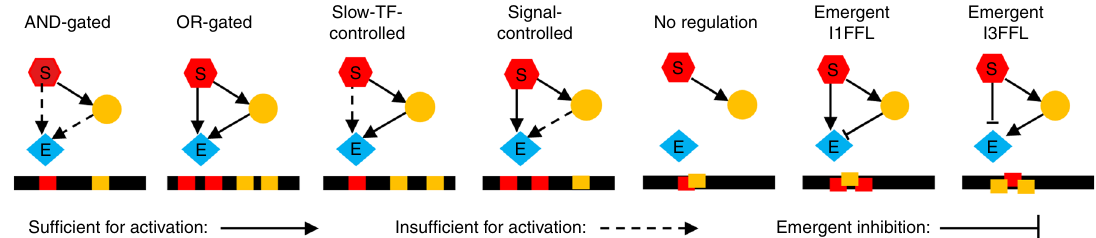
Fig. 2 The distribution of TFBSs determines the regulatory logic of effector expression. We use the pattern of TFBSs (red and yellow bars along black cis - regulatory sequences) to classify the regulatory logic of the effector gene. C1-FFLs are classi fi ed fi rst by whether or not they are capable of simultaneously binding the signal and the TF (left 4 vs. right 3; see Supplementary Fig. 2 and Supplementary Methods for details about overlapping TFBSs). Further classi fi cation is based on whether either the signal or the TF has multiple nonoverlapping TFBSs, allowing it to activate the effector without help from the other (solid arrow). The three subtypes to the right (where the signal and TF cannot bind simultaneously) are rarely seen; they are unless otherwise indicated included in “ Any logic ” and “ non-AND-gated ” tallies, but are not analyzed separately. Two of them involve emergent repression, creating incoherent feed-forward loops (see Supplementary Fig. 1 for full FFL naming scheme). Emergent repression occurs when the binding of one activator to its only TFBS prevents the other activator from binding to either of its two TFBSs, hence preventing simultaneous binding of two